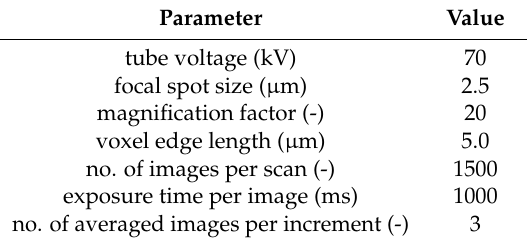
Table 2. CT settings used in all